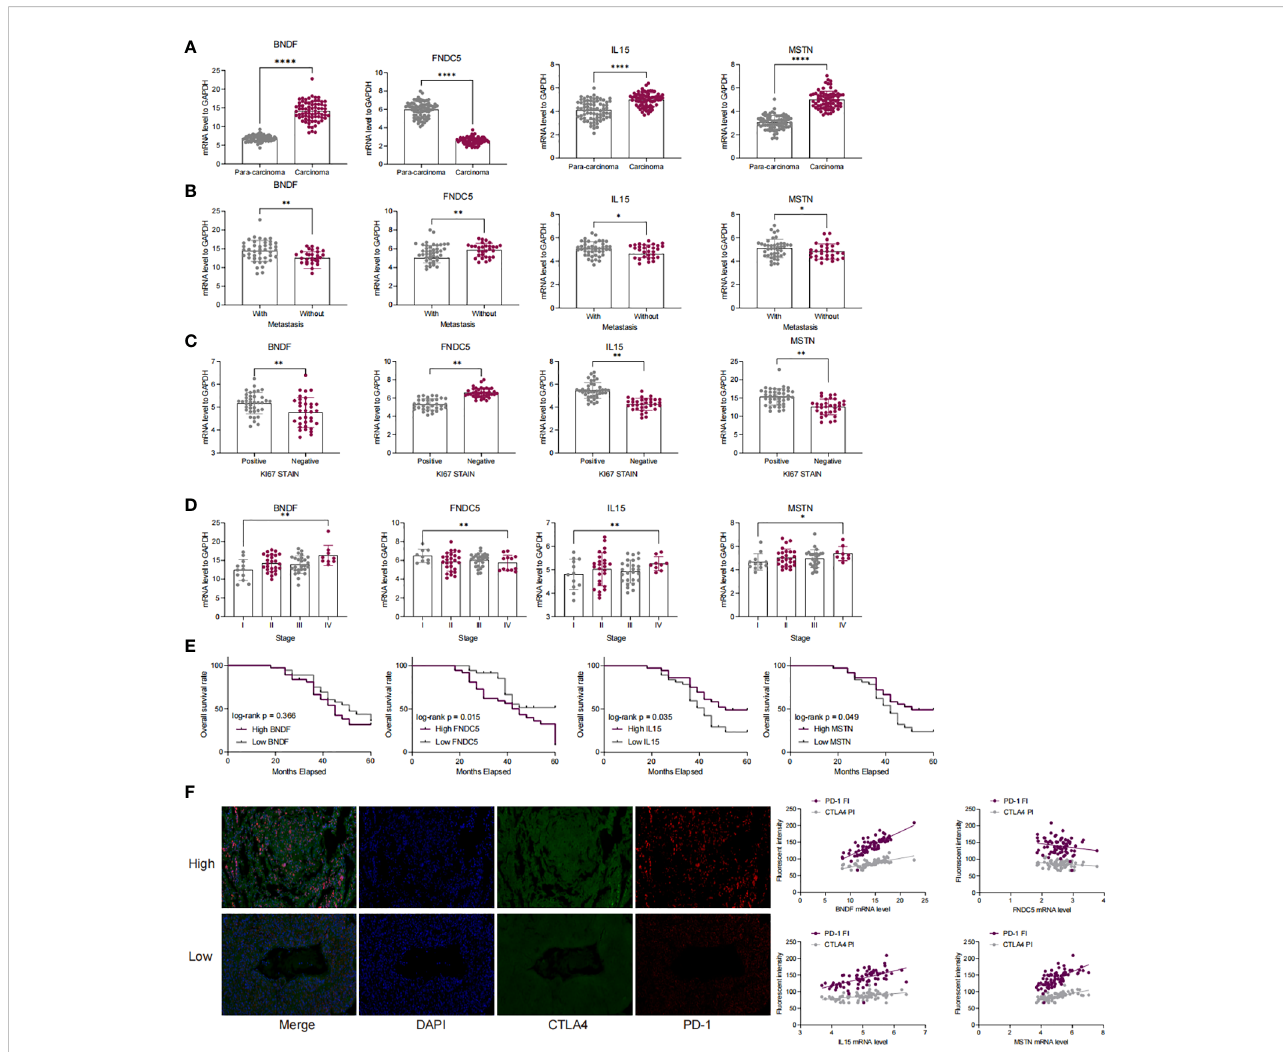
FIGURE 2 The expression of four myokine genes is associated with a poor prognosis in LUAD patients and with immune escape. (A) qRT-PCR detection of mRNA expression of BDNF, FNDC5, IL15, MSTN in cancer and paraneoplastic tissues; (B – D) Correlation of mRNA expression of BDNF, FNDC5, IL15, MSTN with lymph node metastasis, clinical stage, and ki67 in patients with LUAD; (E) Kaplan-Meier analysis of the correlation between the survival time in LUAD patients over 3 to 5 years and the expression levels of BDNF, FNDC5, IL15, and MSTN; (F) PD-1 and CTAL 4 was detected by double-label immuno fl uorescence and analyzed for the correlation of the fl uorescence intensity of PD-1 as well as CTAL 4 with the expression of BDNF, FNDC 5, IL 15, and MSTN. *P<0.5, **P<0.01,